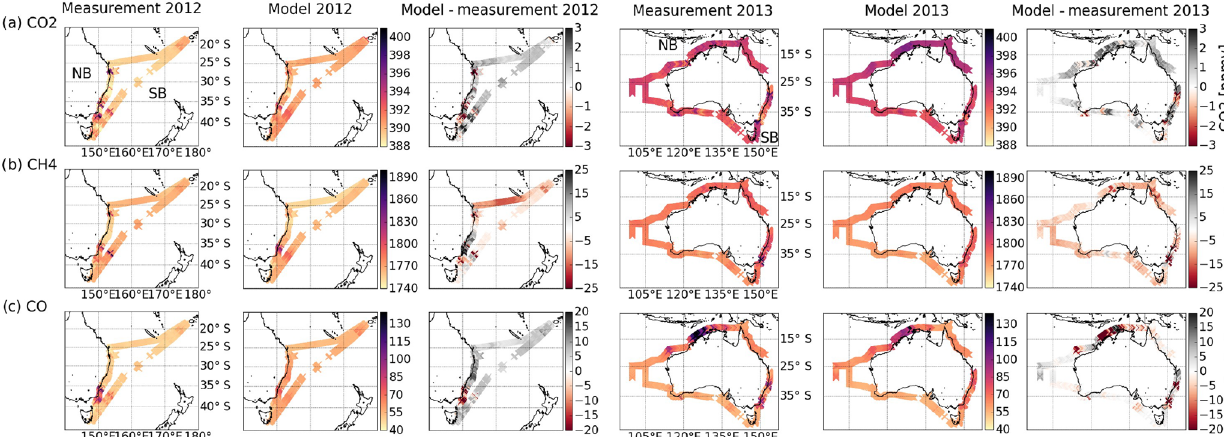
Figure 3. Measured and modelled CO 2 (a) , CH 4 (b) and CO (c) concentrations from the ship cruises in 2012 (left) and 2013 (right). The measurement–model difference is also shown for each gas and ship cruise.